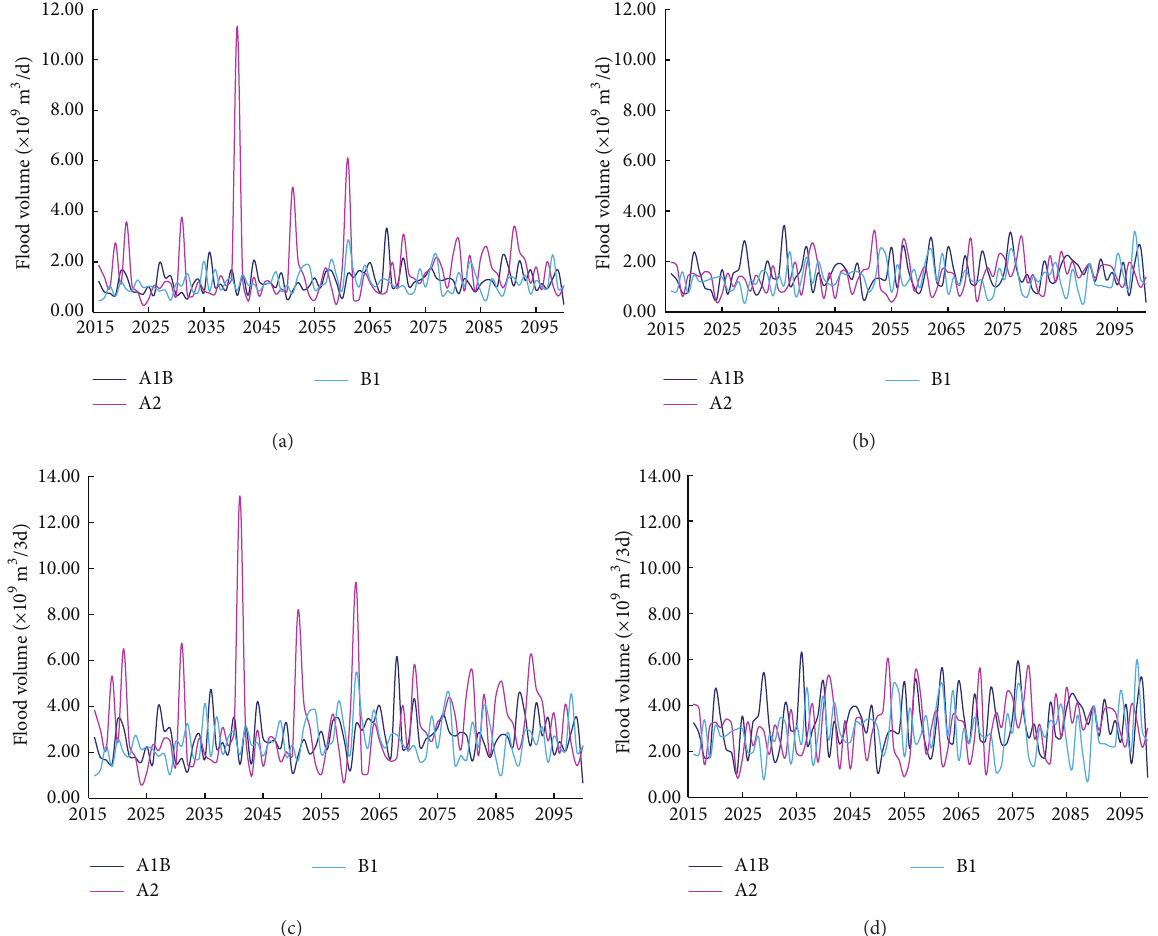
Figure 11: Extreme flood volume changes from 2016 to 2100 under three climate change scenarios. W1 calculated by (a) RX1day and (b) RX3day and W3 calculated by (c) RX1day and (d) RX3day.